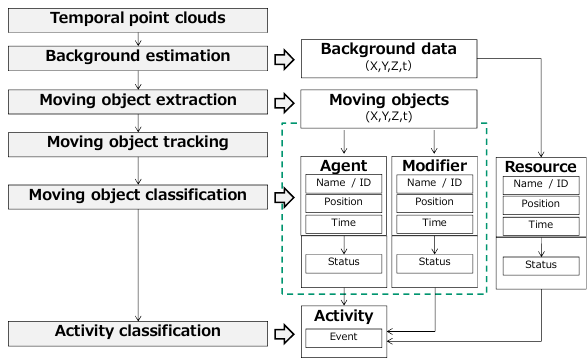
Figure 2. Proposed methodology